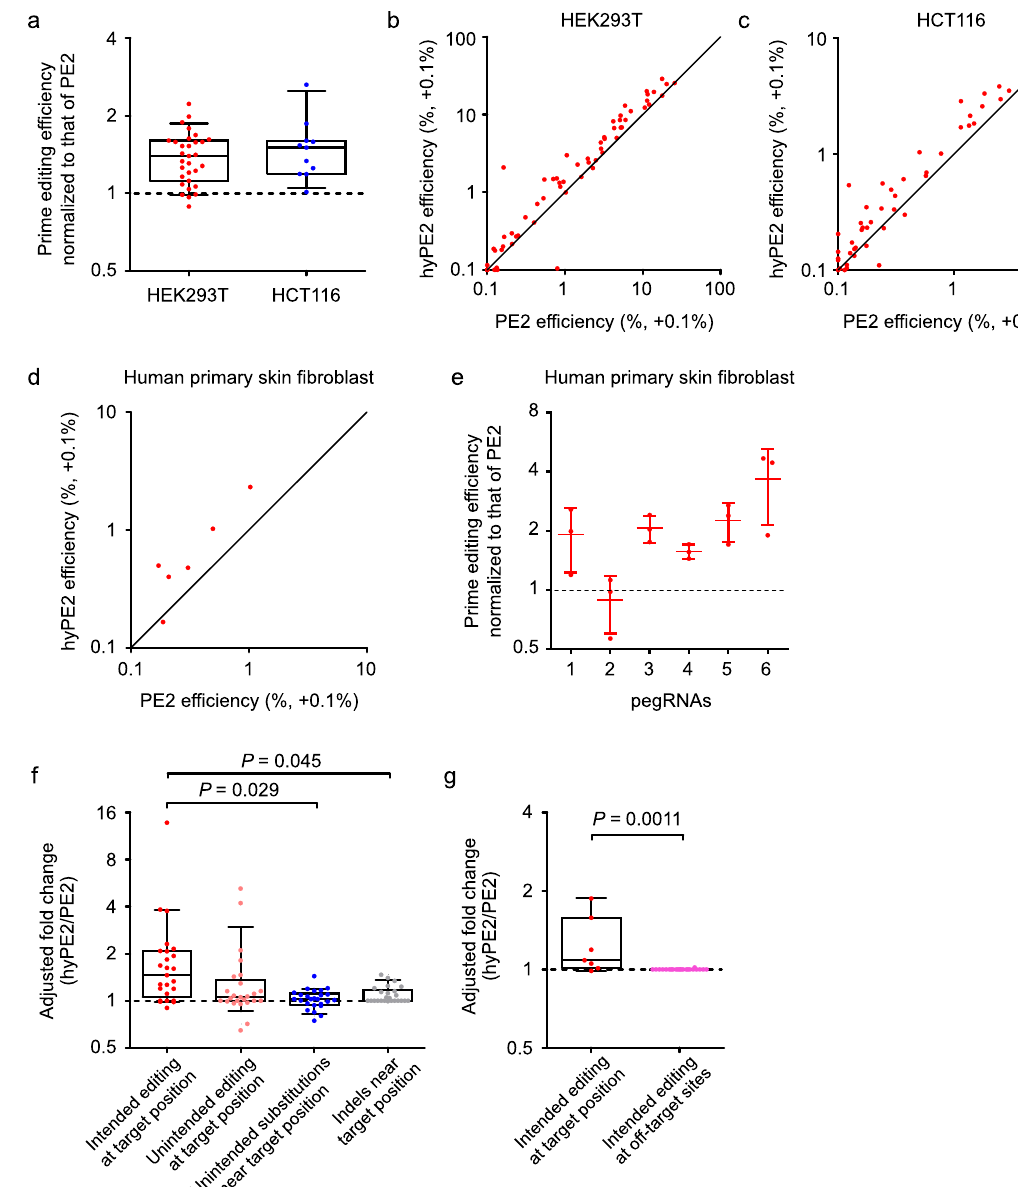
Fig. 3 hyPE2 has higher prime-editing ef fi ciencies than PE2 at endogenous target sites. a Prime-editing ef fi ciencies of hyPE2 normalized to the ef fi ciency of PE2 at the same endogenous targets in HEK293T cells and HCT116 cells. PegRNAs that resulted in PE2-directed prime-editing ef fi ciencies higher than 1% are shown; the number of pegRNAs n = 31 for HEK293T cells and n = 11 for HCT116 cells. b , c Comparison of the prime-editing ef fi ciencies of PE2 and hyPE2 at endogenous sites in HEK293T cells ( b ) and HCT116 cells ( c ). The number of pegRNAs n = 63 (b) and n = 51 ( c ). d Comparison of the prime- editing ef fi ciencies of PE2 and hyPE2 at 6 endogenous sites in primary human skin fi broblasts. e Prime-editing ef fi ciencies of hyPE2 normalized to the ef fi ciency of PE2 at the same target sequences in primary human skin fi broblasts. Adjusted fold increases are shown on the y axis. Data are means ± S.D. for three independent biological replicates. f Prime editing and unintended editing frequencies of hyPE2 normalized to those of PE2 at the same endogenous targets in HEK293T cells. Adjusted p -values calculated by one-way ANOVA with post hoc analysis by Tukey ’ s multiple comparisons are shown. For brevity, we have not included p -values when the differences between the values of the two groups are not statistically signi fi cant. The number of pegRNAs n = 25. g On-target and off-target editing frequencies of hyPE2 normalized to those of PE2 at the same endogenous targets in HEK293T cells. The p -value was calculated by two-tailed, unpaired Student ’ s t -test. The number of pegRNAs n = 7 (on-target) and the number of pegRNA off-target pairs n = 22. a , f , g Data of minimum-to-maximum values are presented. For the boxes, the top, middle, and bottom lines represent the 25th, 50th, and 75th percentiles, respectively. The whiskers indicate the 10th- and 90th-percentile values. b – d The black line indicates y = x . The data points represent the average prime editing ef fi ciency from three biological replicates at each target sequence. 0.1% was added to all ef fi ciency values so that log scales could be used for both the x- and y axes. Source data are provided as a Source Data fi